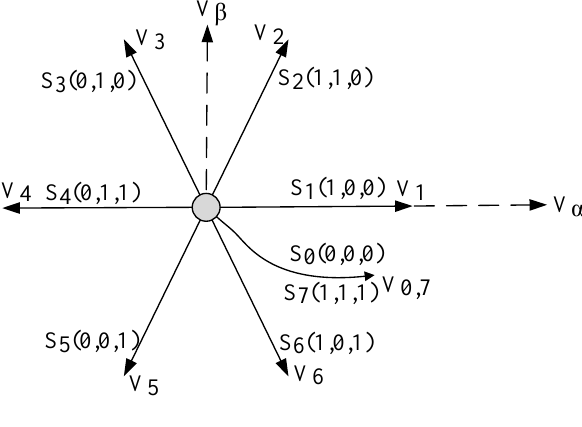
Figure 3. Voltage vectors generated by the inverter ( V i )